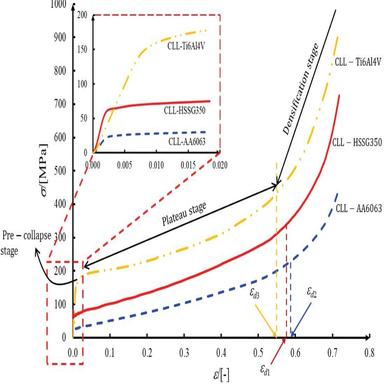
Numerically predicted stress-strain curves of CLL materials ( ¯ 0.261 = ) made of different cell-wall materials, i.e. HSSG350, AA6063 and Ti6Al4V.